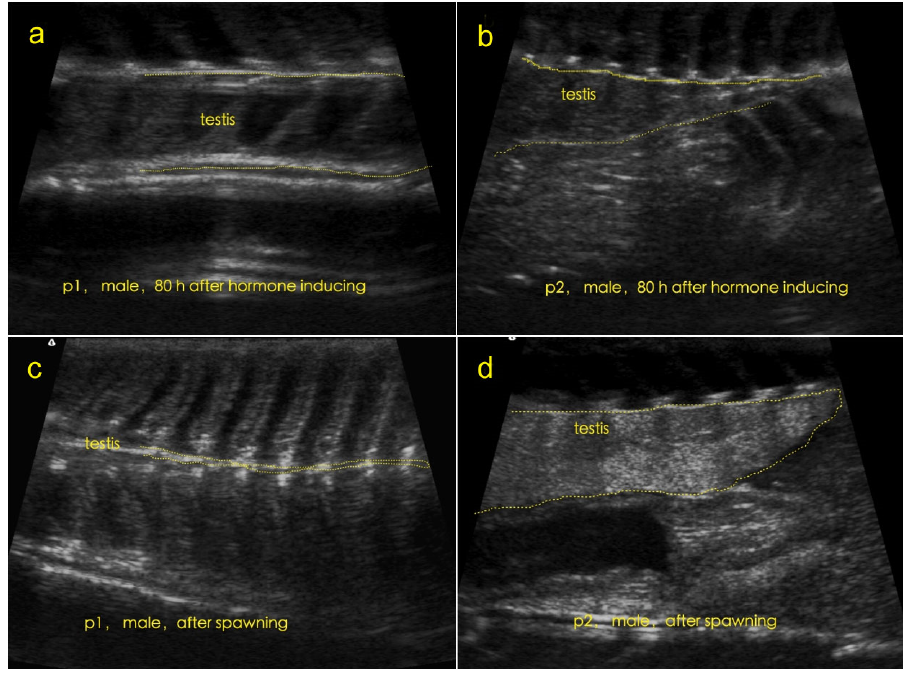
Figure 4. Ultrasound images of testes of mature Hucho bleekeri after hormonal induction. ( a,b ) 80 h after hormonal induction; ( c,d ) after spawning.